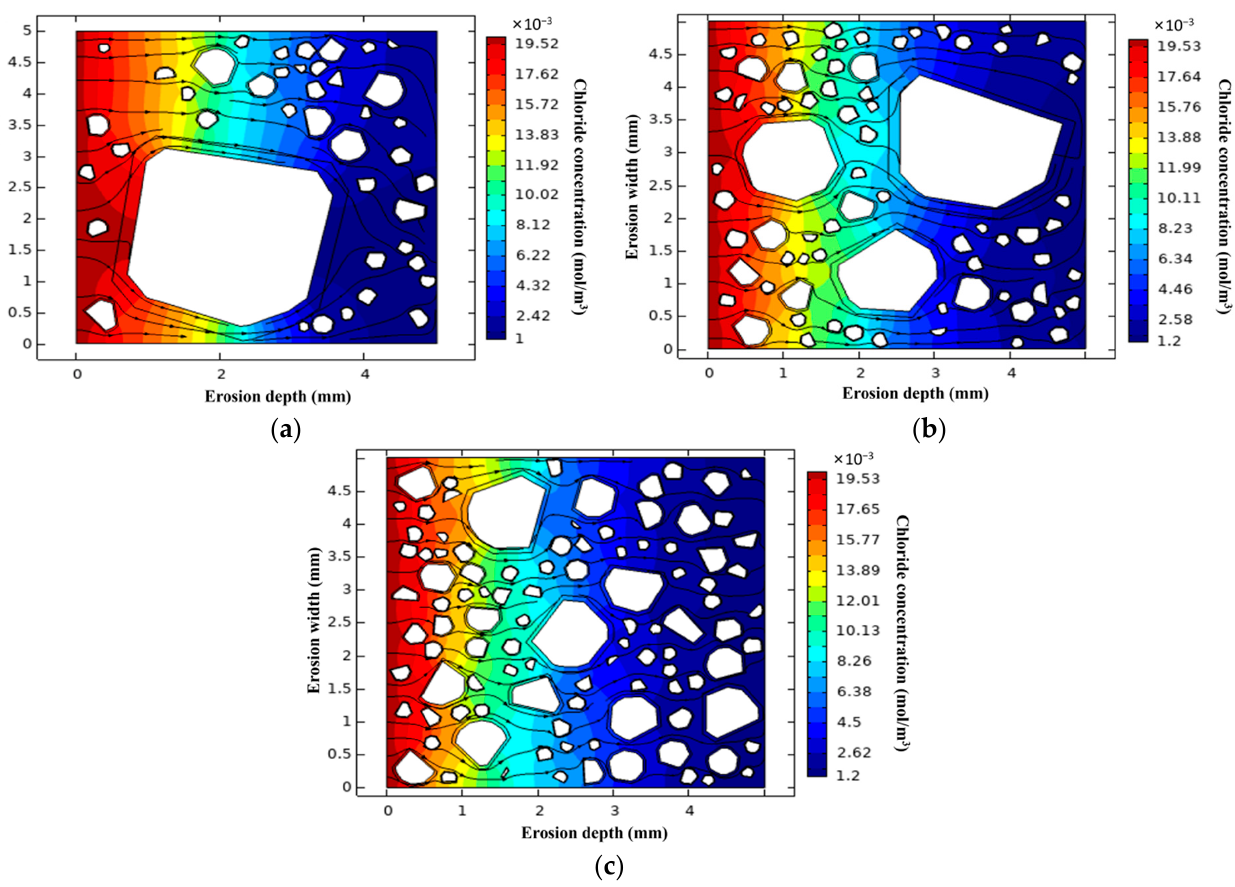
Figure 13. Simulation results of L-UHPC random aggregate model of LWA with different particle sizes: ( a ) 0.15–4.75 mm; ( b ) 0.15–2.36 mm; ( c ) 0.15–1.18 mm.